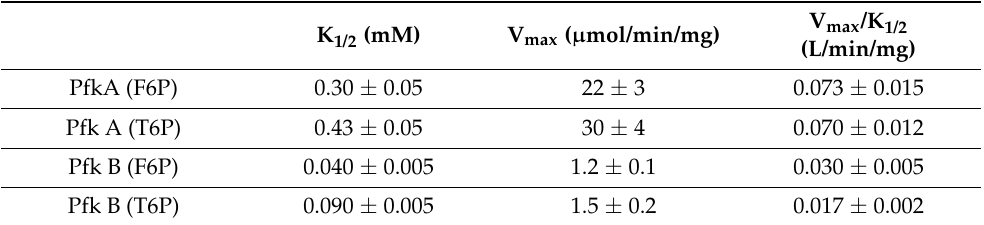
Table 3. The kinetics of Pfk A and Pfk B with F6P and T6P substrates.